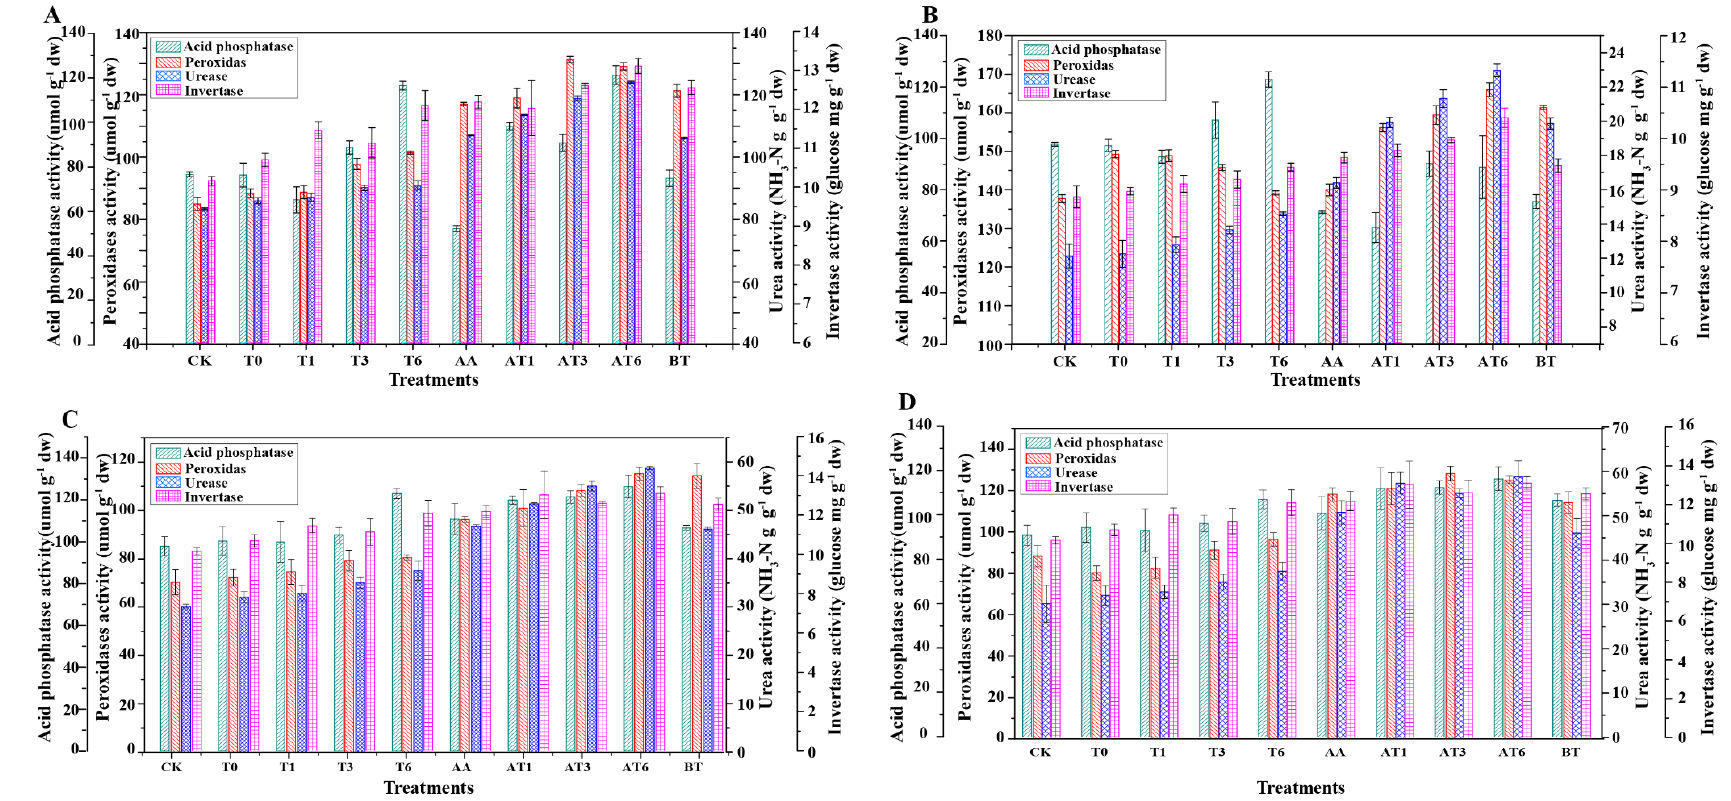
Figure 3. The soil’s extracellular enzyme activities, including invertase, urease, peroxidase and acid phosphatase in sandy soil and mountain soil during two growth seasons. ( A ) the enzyme activities of different treatments in sandy soil during the FS; ( B ) the enzyme activities of different treatments in sandy soil during the SS; ( C ) the enzyme activities of different treatments in mountain soil during the FS; ( D ) the enzyme activities of different treatments in mountain soil during the SS.